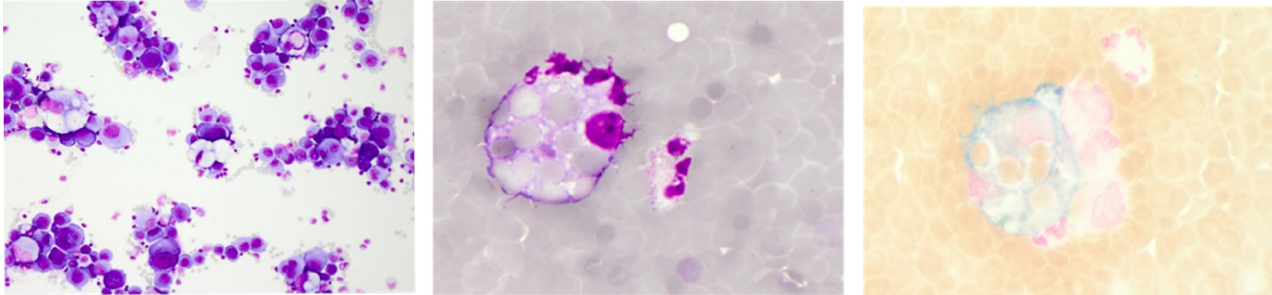
Figure 2. Representative CSF cytology illustrating neoplastic leptomeningeal spread with carcinoma cells ( left , May–Grünwald staining) and an acute subarachnoid haemorrhage depicting an erythrophage ( middle , May–Grünwald staining) and an erythrosiderophage ( right , Berliner blue staining). Cytology specimen kindly provided by the Department of Laboratory Medicine,